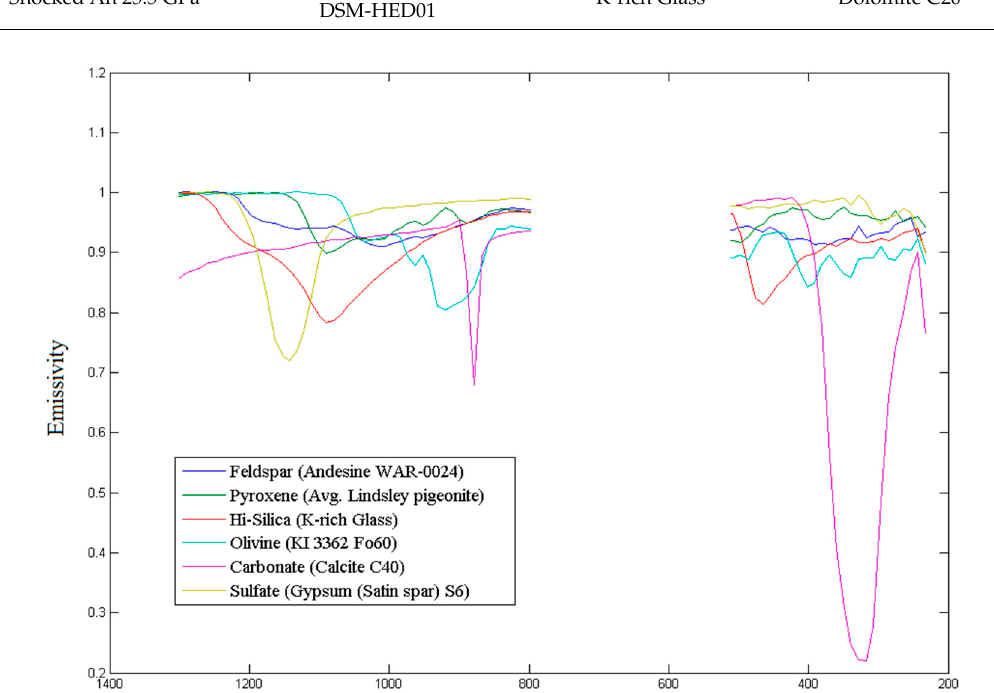
Figure 19. Spectral shapes of representative minerals for mineral groups included in the surface model.